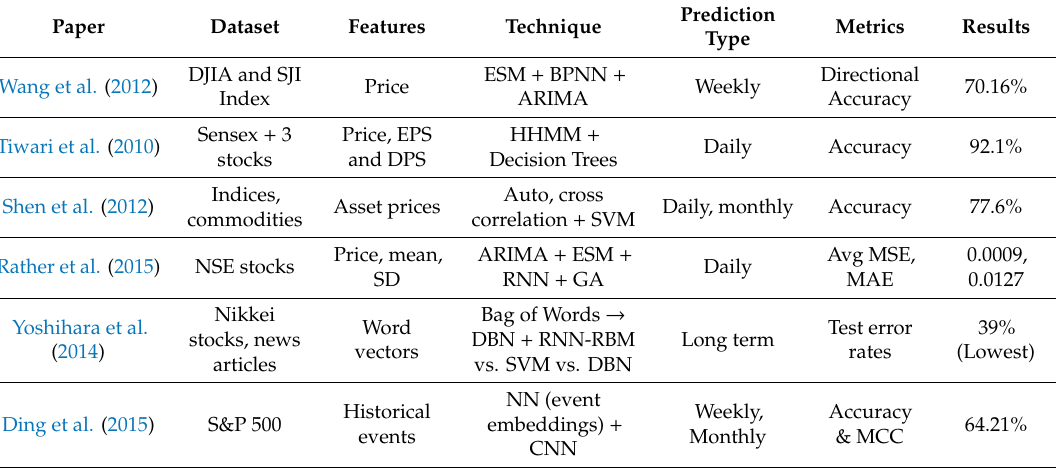
Table 3. Summary of literature on hybrid approaches applied to stock